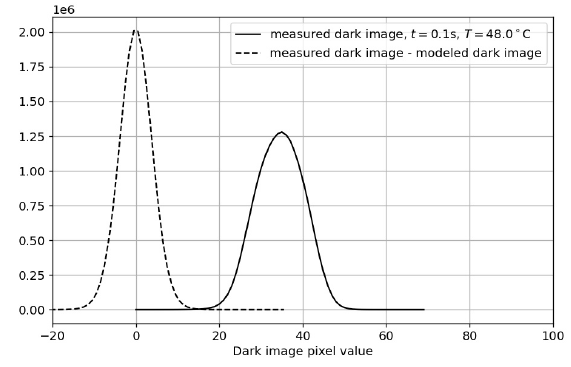
Figure 8. Histograms of a measured dark image and its dark corrected image.